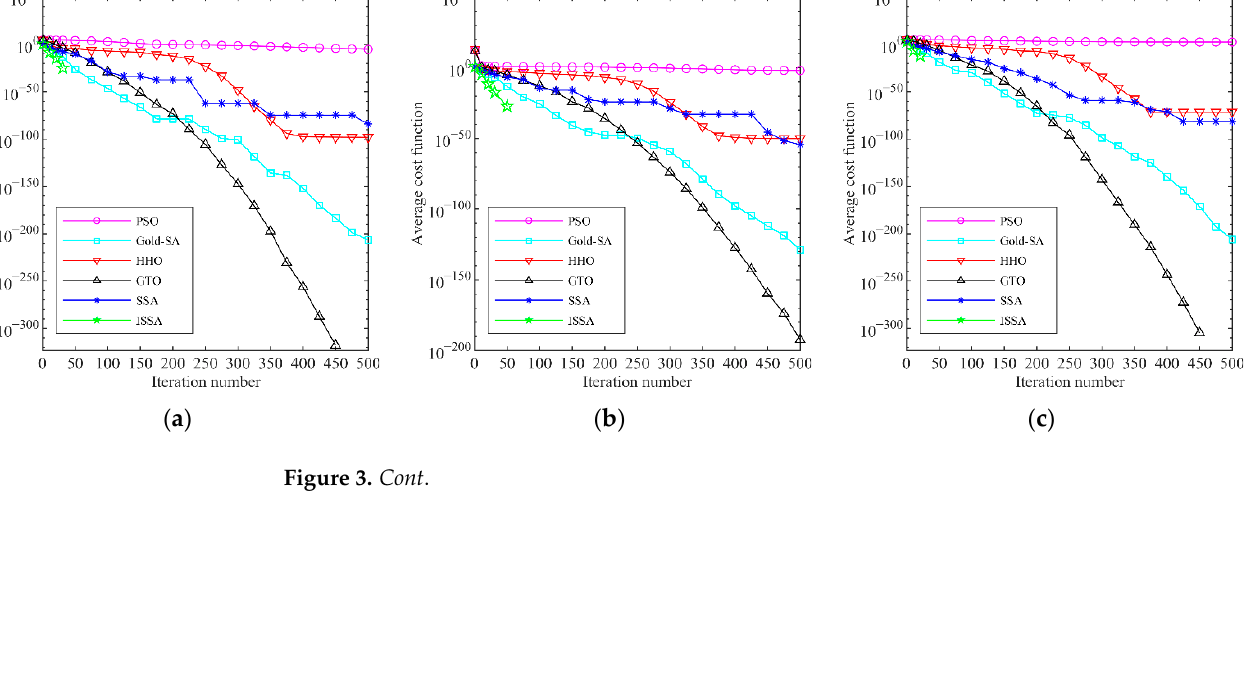
Figure 2. Radar chart of sort of algorithm.